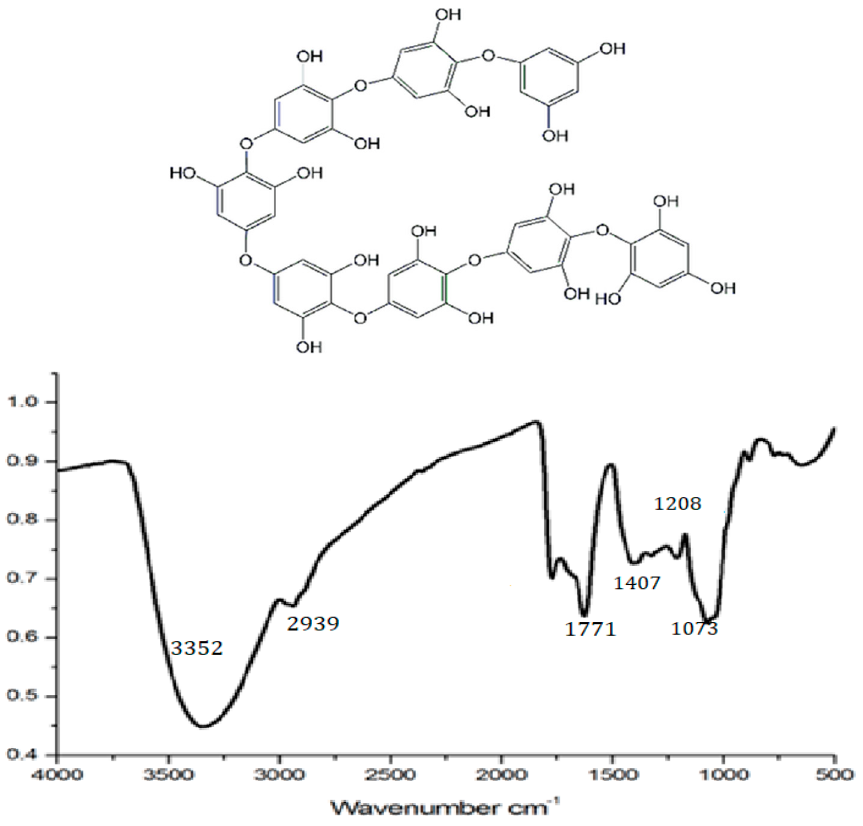
Figure 2. The FT-IR spectrum of phlorotannins extract from S. linifolium marine alga.